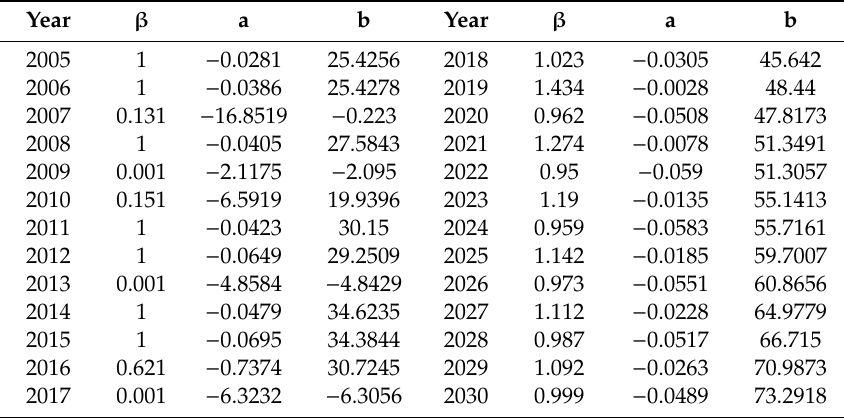
Table 4. The value of NMGM Parameters in